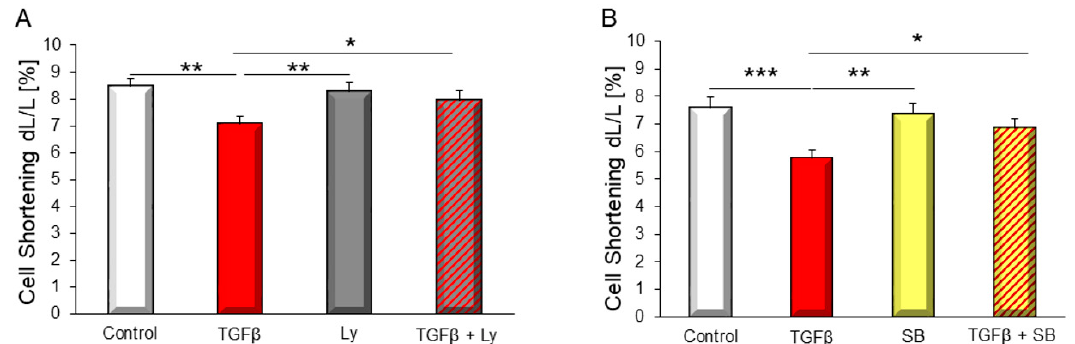
Figure 4. Cell shortening of isolated cardiomyocytes was determined after stimulation with 1 ng/mL TGF β 1 with and without addition of PI3K inhibitor Ly294002 (Ly, 1 µ M) ( A ) or ALK5 inhibitor SB431542 (SB, 1 µ M) ( B ). Data are shown as means ± SEM of 71 to 87 cells of four to seven different rat cardiomyocytes preparations. Significance is indicated by * p < 0.05, ** p < 0.01 *** and p < 0.001.